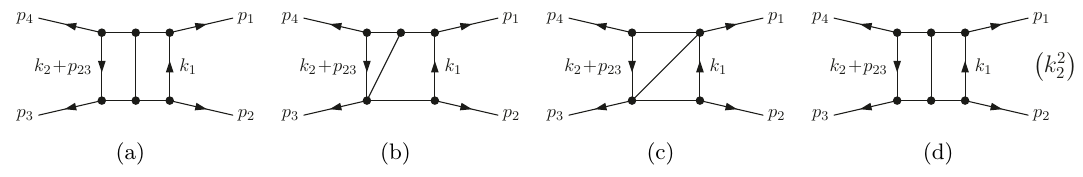
Figure 6 . Representative two-loop planar boxes that admit a d log